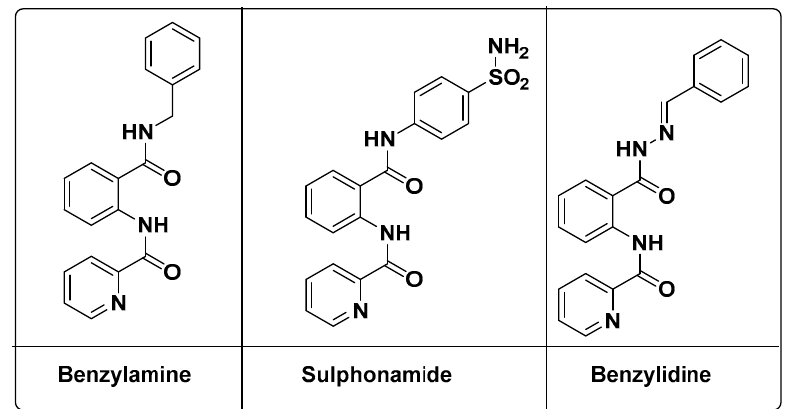
Figure 1. Structural similarities and pharmacophoric features of reported and designed anthranilate diamides as antidiabetic agents compared to the reported reference drug.